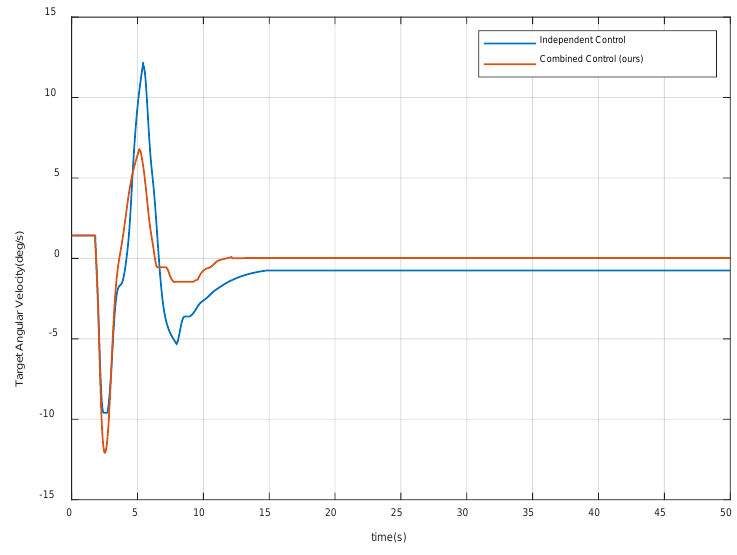
Figure 15. Angular velocity of the target spacecraft.